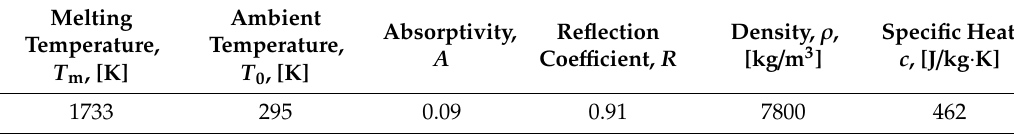
Table 3. Physical properties of low-carbon steel (1.0402) [16].